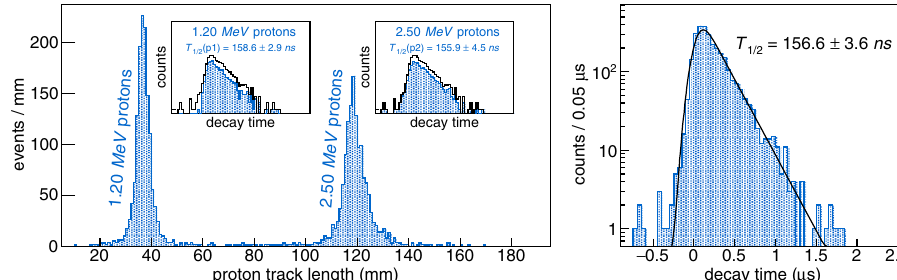
Fig. 3 Experimental proton track length and decay time distributions. The left plot shows the distribution of the track lengths of the protons. The right plot is the decay-time distribution obtained from the time difference measured between the ion stopping point and the proton track starting point. It is least-square fi tted (black) with an exponential convoluted with a Gaussian function to account for the time-measurement resolution. The inlays of the left plot show the decay-time distributions of each proton group (blue online) compared to the total distribution